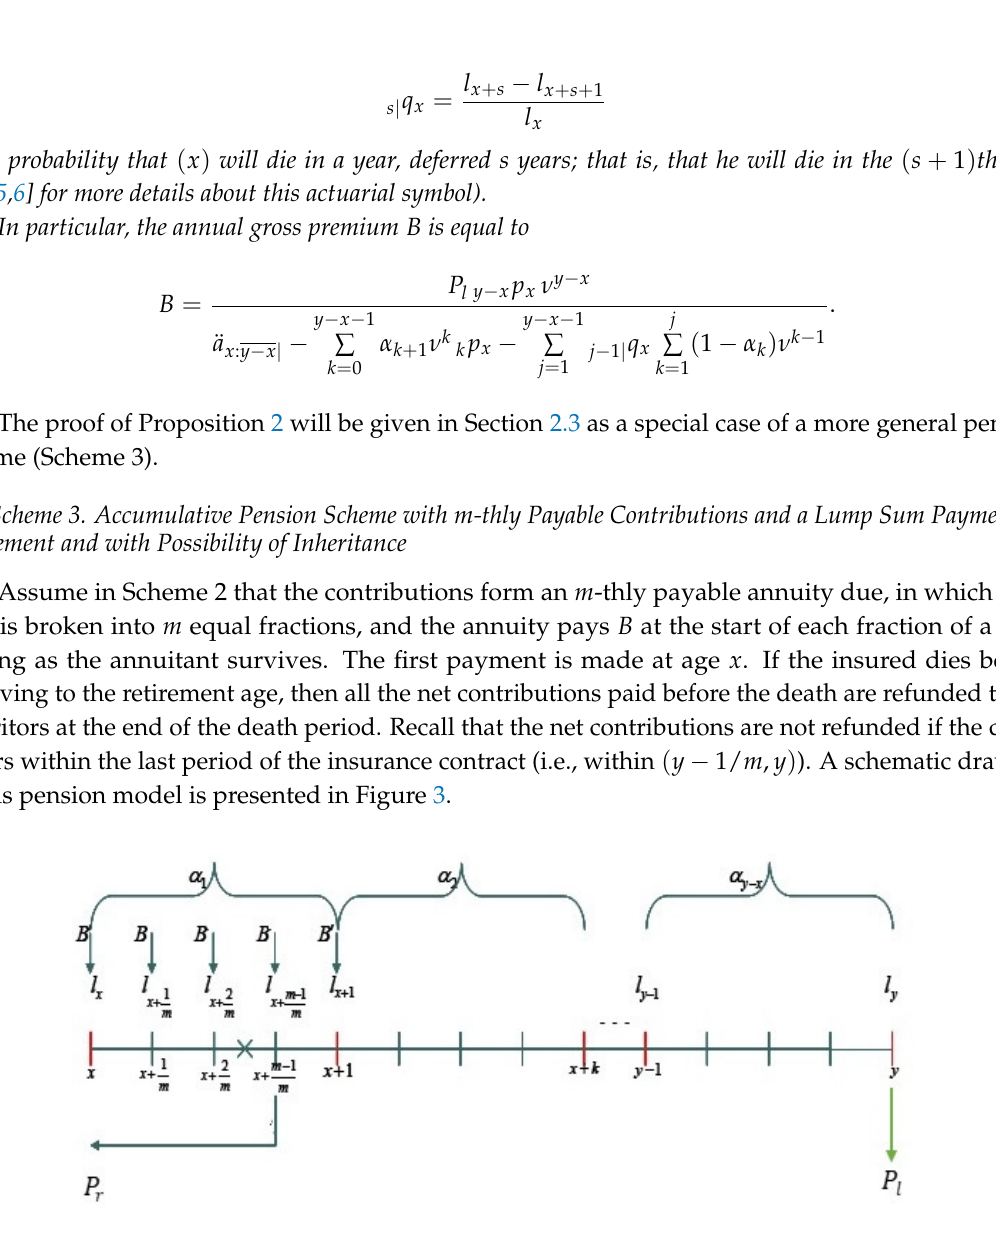
Figure 3. Schematic drawing of the accumulative pension scheme with m -thly payable contributions and a lump sum payment on retirement and with possibility of inheritance. The cross indicates the moment of